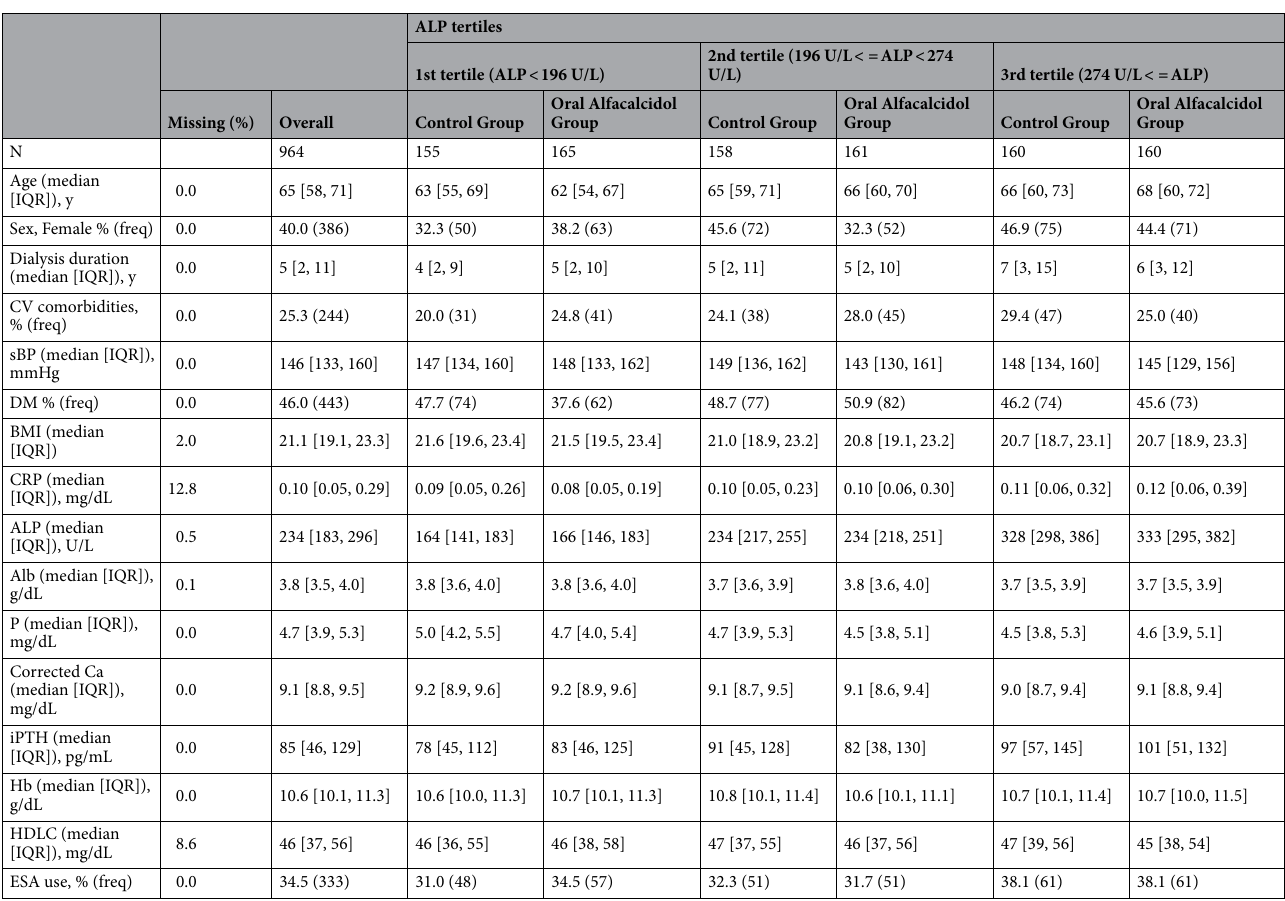
Table 1. Baseline characteristics of study participants according to ALP tertiles. ALP alkaline phosphatase; CV cardiovascular disease; sBP systolic blood pressure; DM diabetes mellitus; BMI body mass index, CRP C-reactive protein, Alb serum albumin, P serum phosphate, Corrected Ca albumin-corrected serum calcium, iPTH intact parathyroid hormone, Hb hemoglobin, HDLC high-density lipoprotein cholesterol, ESA erythropoiesis-stimulating agents, IQR interquartile